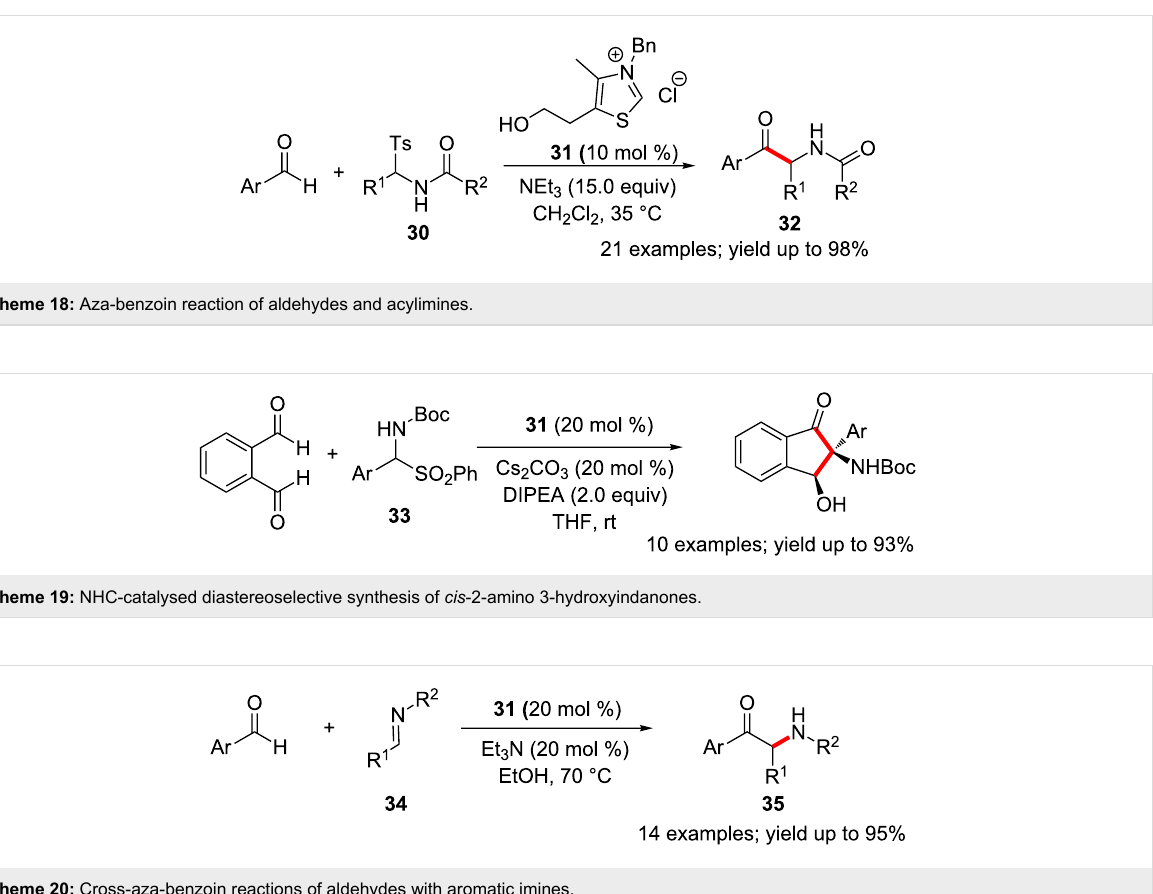
Scheme 20: Cross-aza-benzoin reactions of aldehydes with aromatic